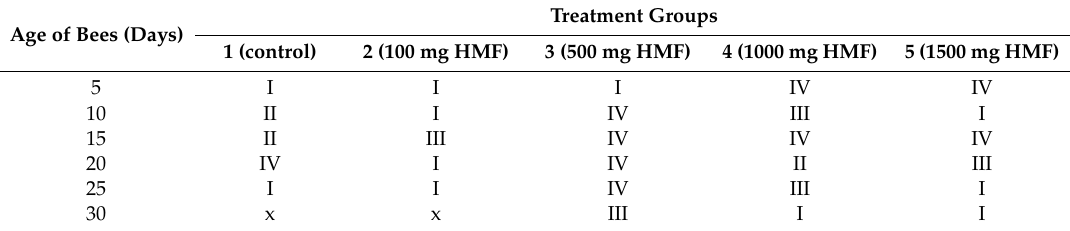
Table 1. Results of the semi-qualitative analyses of midgut cell death using the In Situ Cell Death Detection Kit (ISCDDK) immunohistochemical method. The results represent the percentage of positive cells in midgut tissue treated with ISDDK: (I) individual positive cells; (II) range between 0% and 20% positive cells; (III) range between 21% and 60% positive cells; (IV) range between 61% and 90% positive cells; (x) no samples available. Treatment groups: 1. Untreated control; 2. 100 mg / kg of HMF in Apifonda; 3. 500 mg / kg of HMF in Apifonda; 4. 1000 mg / kg of HMF in Apifonda; 5. 1500 mg / kg